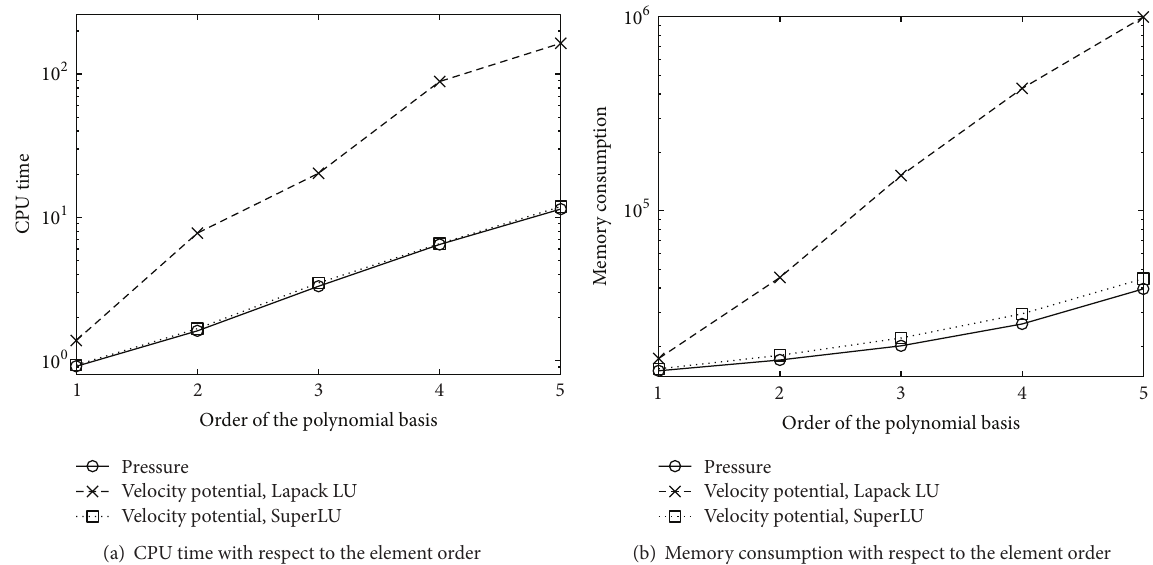
Figure 2: CPU time (in seconds) and memory (in kilobytes) consumed for solving a time-dependent problem with different formulations. The number of time steps is fixed to be 400, and square-element meshes with mesh step size ℎ = 0.1 are used in both media.